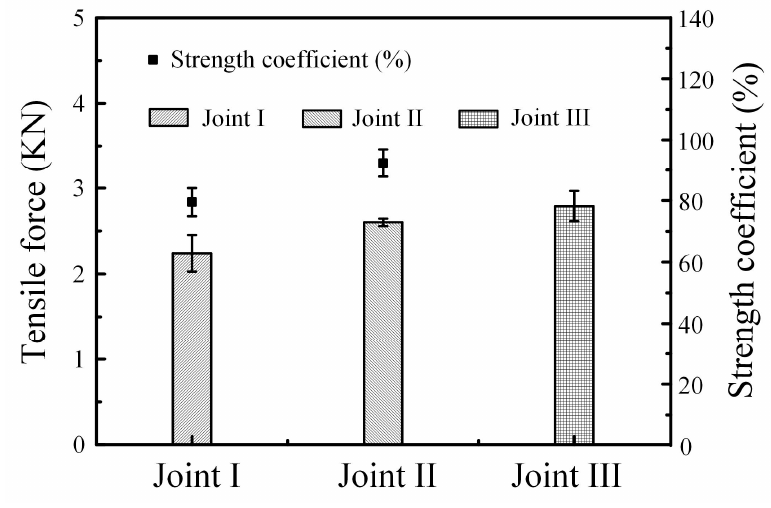
Figure 9. Tensile force in different joints listed in Table 3.